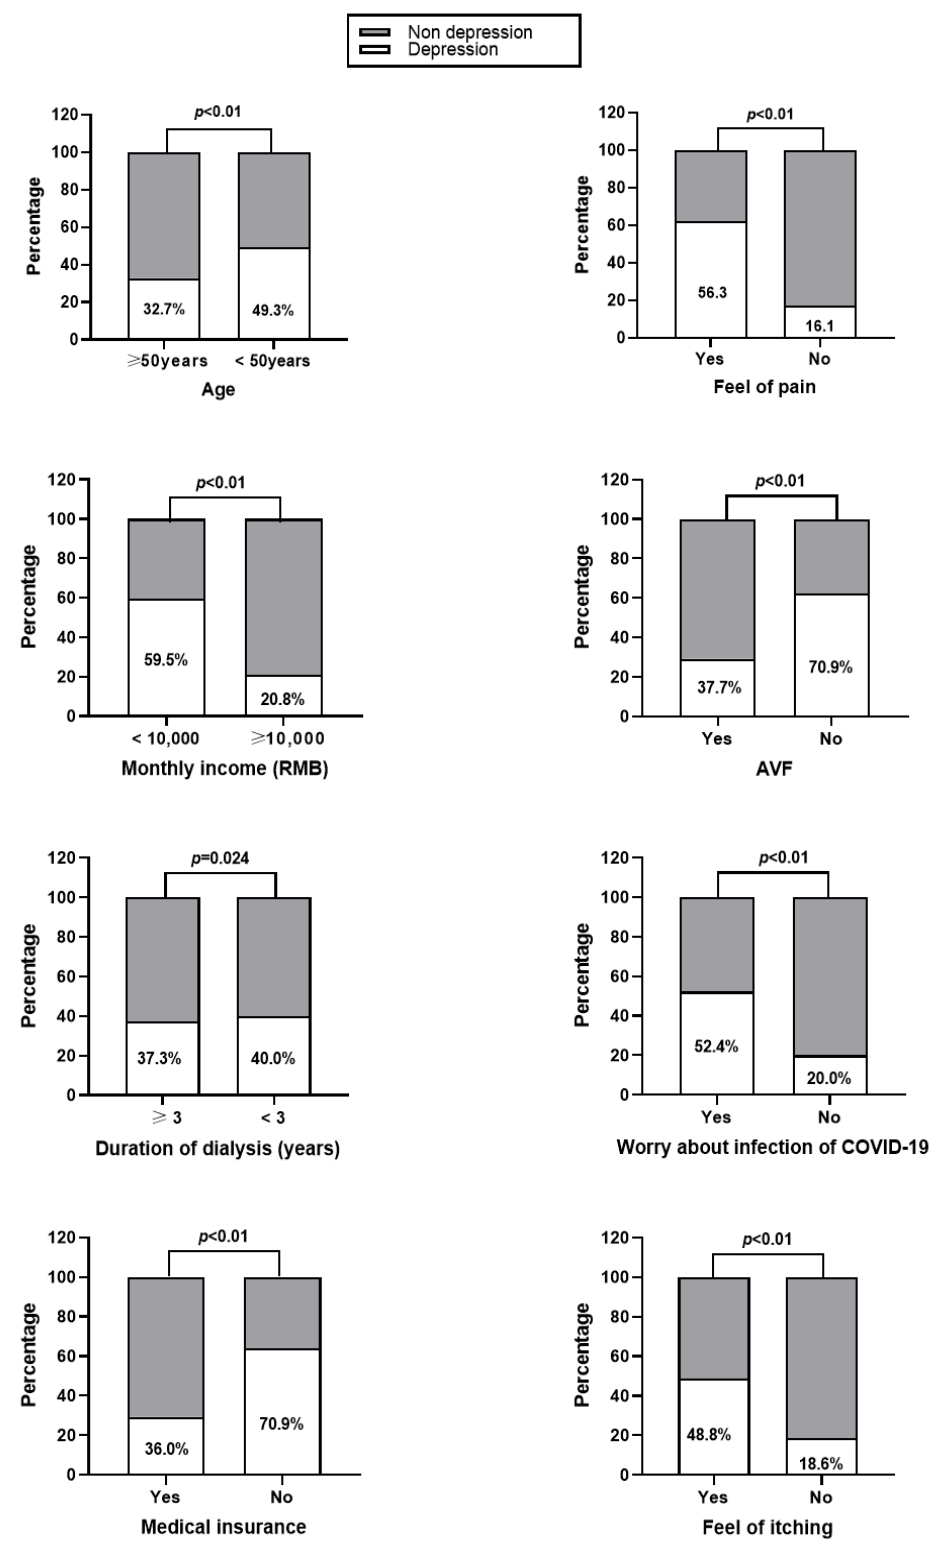
Figure 2. Figure 2. Single-factor analysis of depression in the MHD patients with di ff erent demographic char- acteristics.